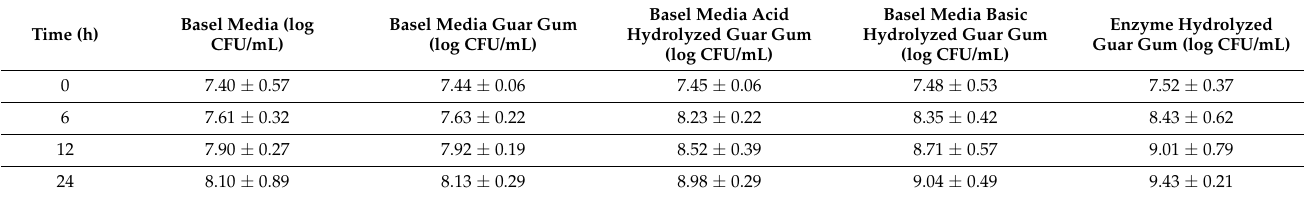
Table 3. Probiotic potential of partially hydrolyzed guar gum